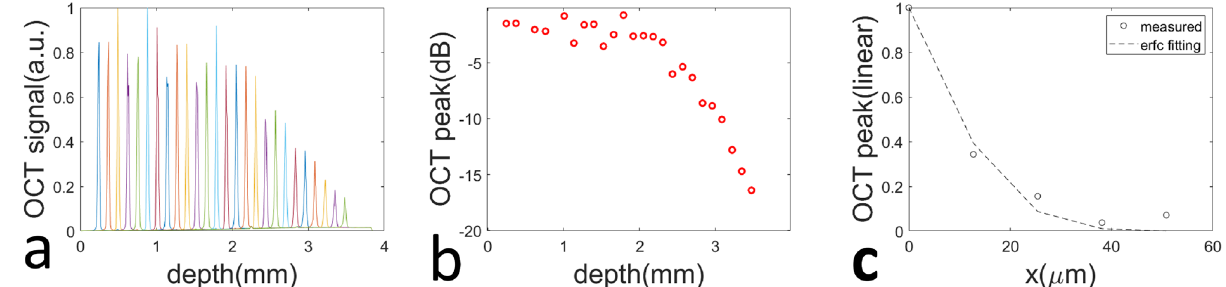
Figure 3. ( a ) Ascans obtained from a mirror at different imaging depths; ( b ) peak signal magnitude for Ascans obtained from different depths; ( c ) lateral profile obtained when the probe was scanned across a specular surface with step reflectivity profile.